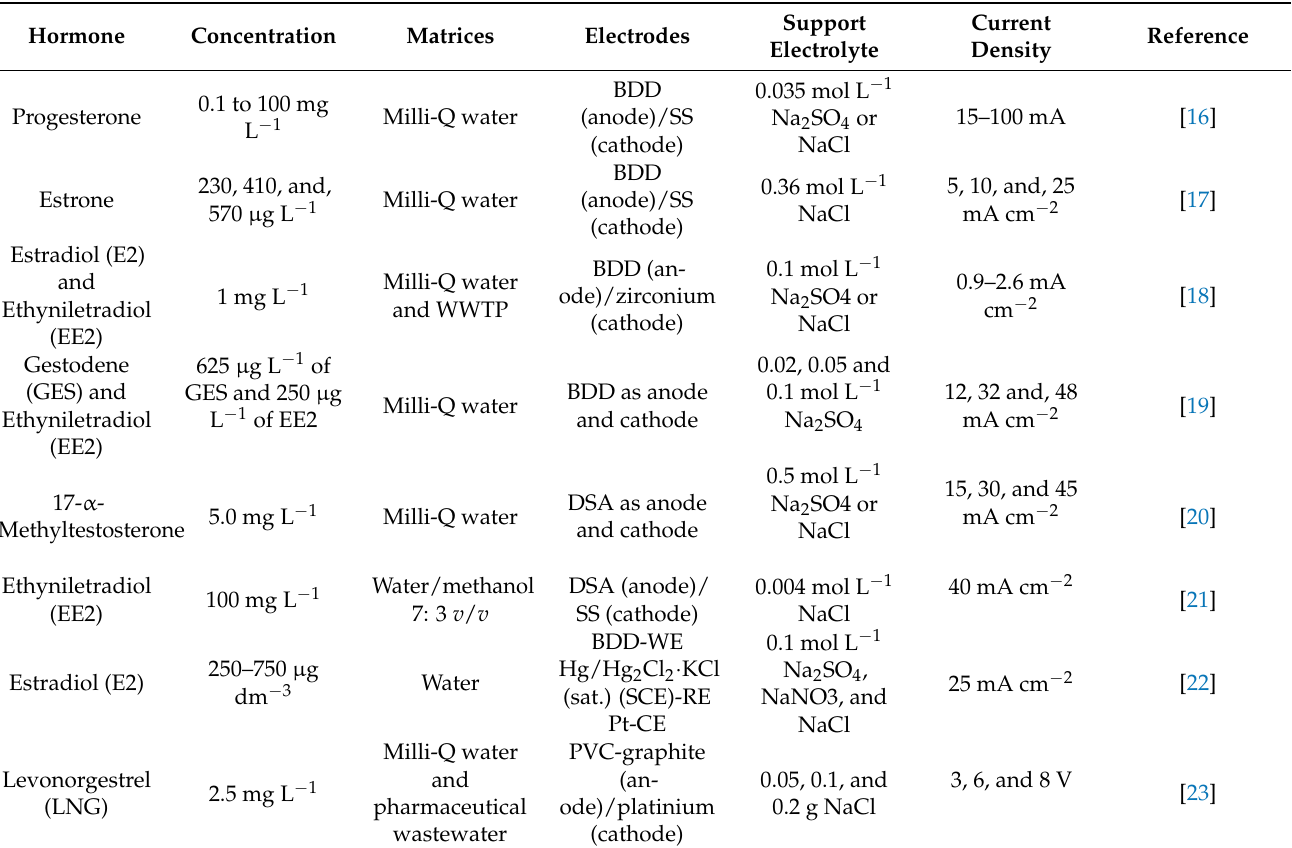
Table 2. Anodic oxidation (AO) studies applied for the removal of